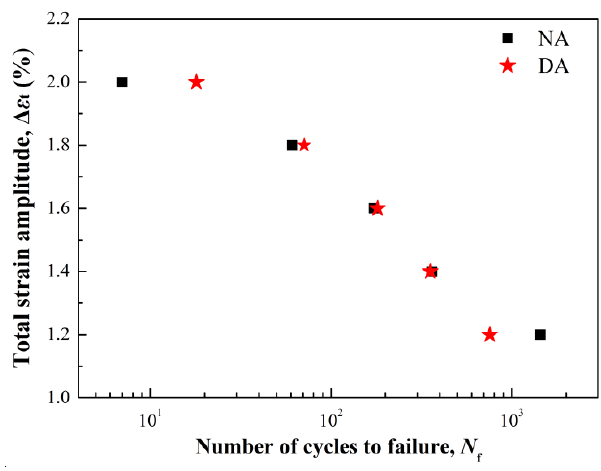
Figure 8. Fatigue life of the alloy under different aging conditions.